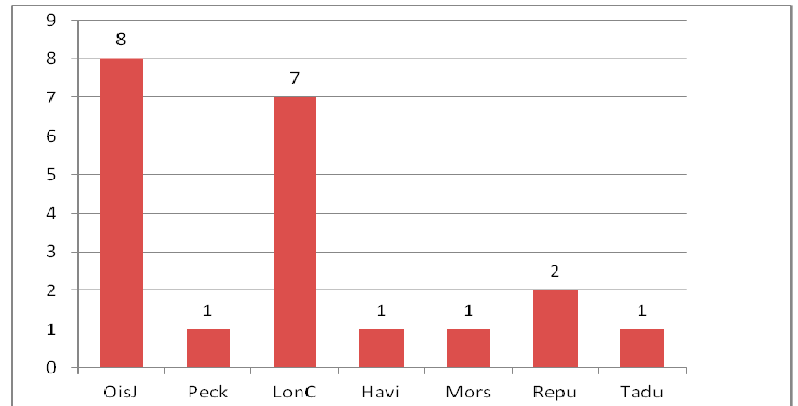
Figure 8. Composition of Curculionoidea species between Early Eocene localities.